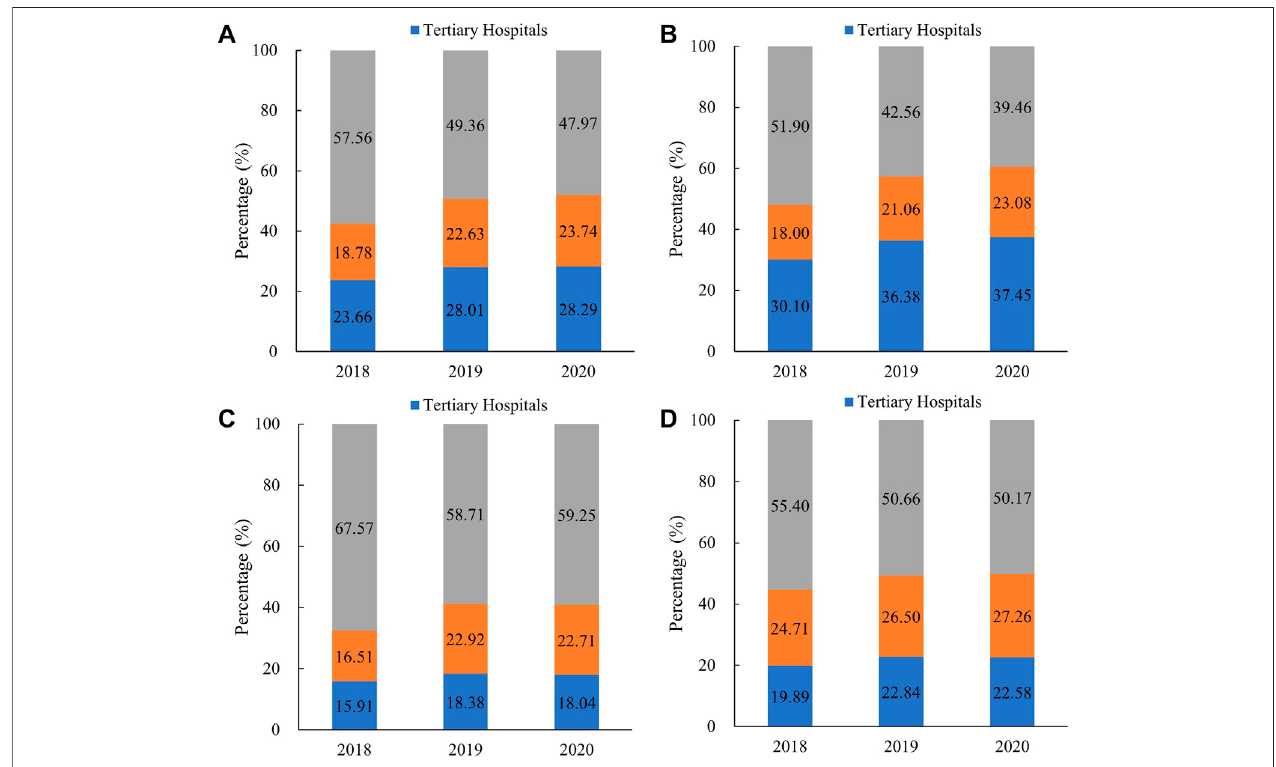
FIGURE 3 | Proportional consumption (%) of antibiotics utilized in different medical institutions in China, 2018 – 2020. (A) Overall, (B) eastern China, (C) central China, and (D) western China. Note: Data of 24 provinces were involved.